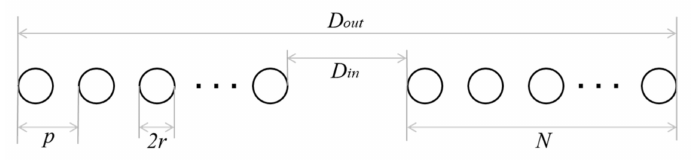
Figure 6. The cross-sectional structure model of the planar coil.